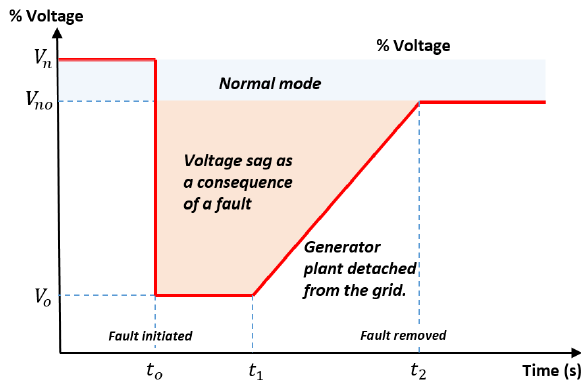
Figure 8. Generic fault ride-through capability curve.